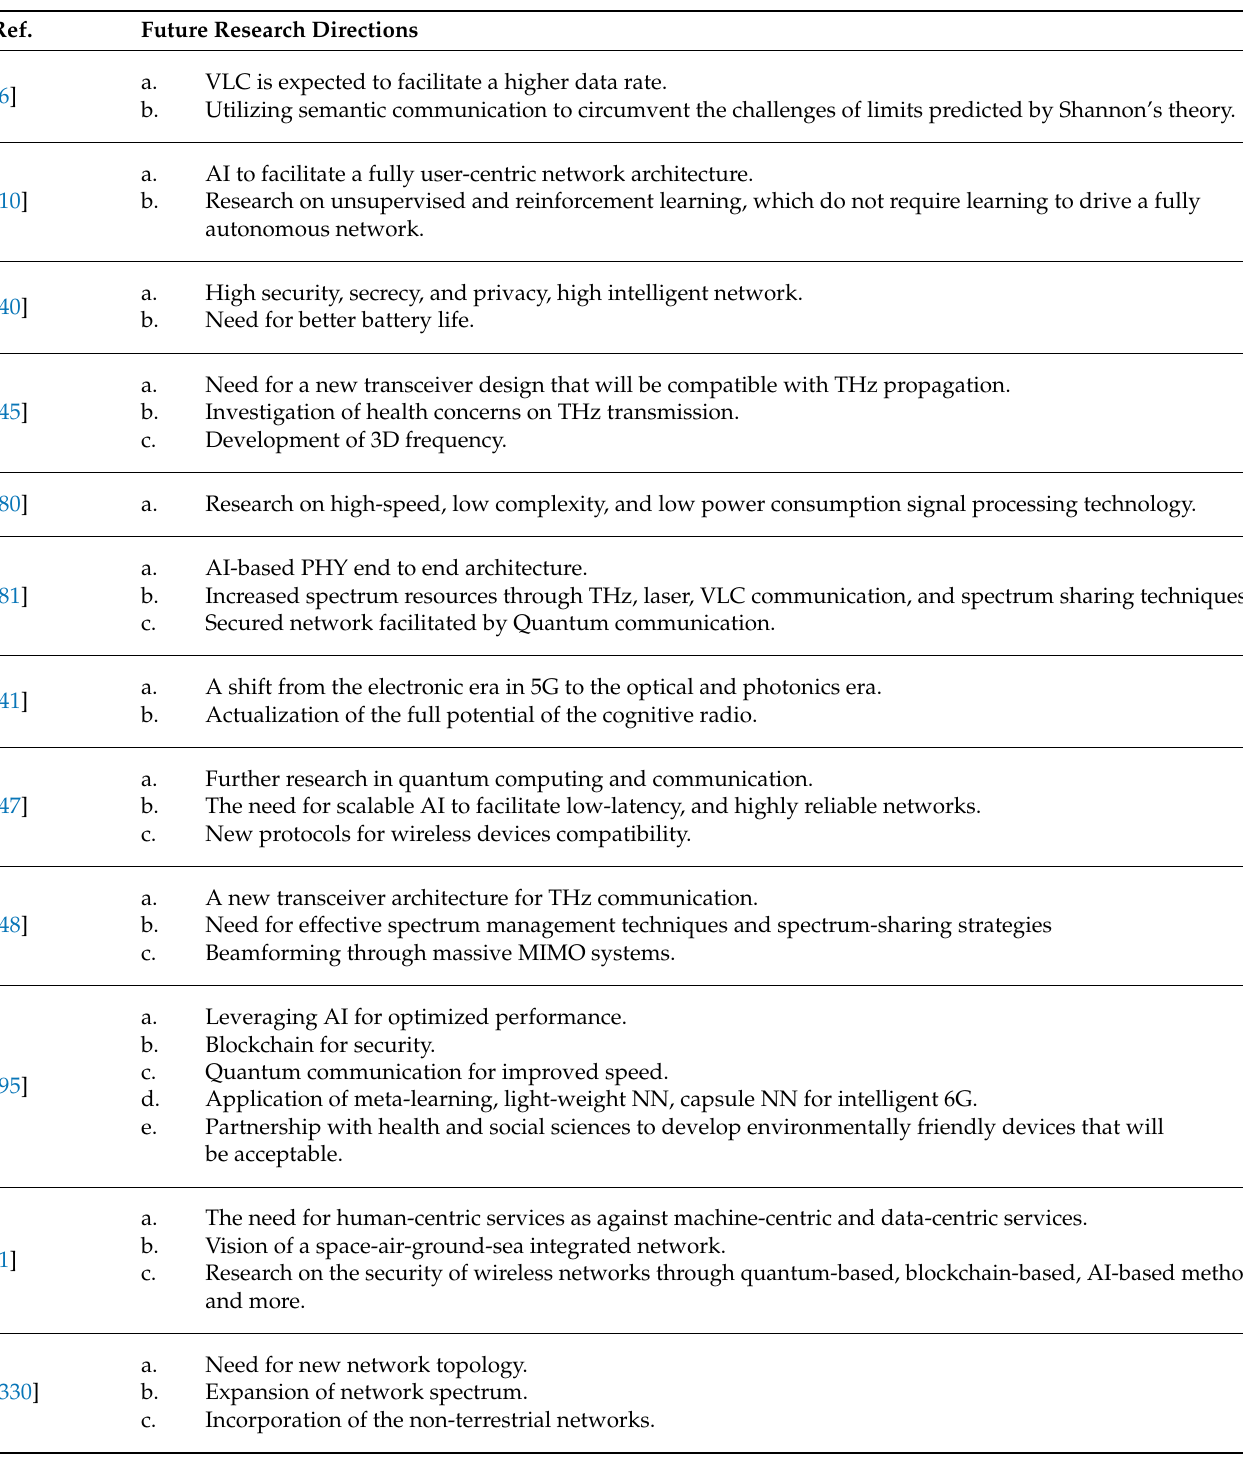
Table 20. Proposed Research Directions in 6G Wireless